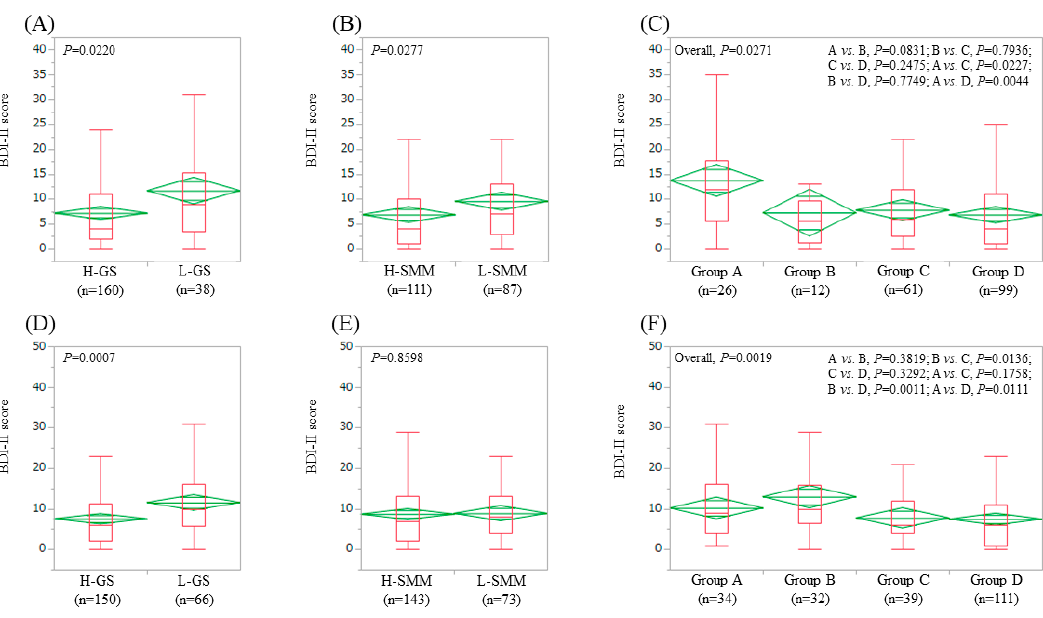
Figure 3. BDI-II score stratified by GS and SMM for male patients ( n = 198). ( A ) Lower GS (L-GS) vs. Higher GS (H-GS). ( B ) Lower SMM (L-SMM) vs. Higher SMM (H-SMM). ( C ) Comparison among four types (group A, B, C and D). BDI-II score stratified by GS and SMM for female patients ( n = 216). ( D ) L-GS vs. H-GS. ( E ) L-SMM vs. H-SMM. ( F ) Comparison among four groups (group A, B, C and D). Group A indicates L-GS and L-SMM. Group B indicates L-GS and H-SMM. Group C indicates H-GS and L-SMM. Group D indicates H-GS and H-SMM.